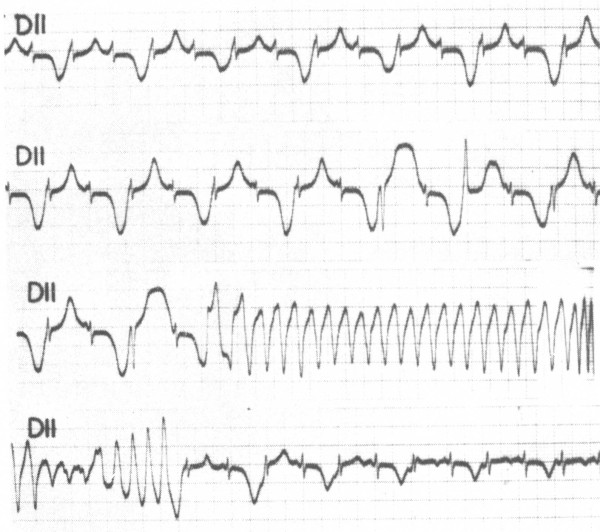
5-year-old patient affected by LQTS with congenital deafness. Tracing recorded during a syncopal episode. T wave alternans precedes the onset of torsade de pointes. In this case, it is also evident that TdP is not preceded by a pause. (From C. Pernot: Le syndrome cardio-auditif de Jervell et Lange-Nielsen. Aspects electrocardiographiques. Proc Ass Europ Paediat Cardiol 1972, 8:28–36).